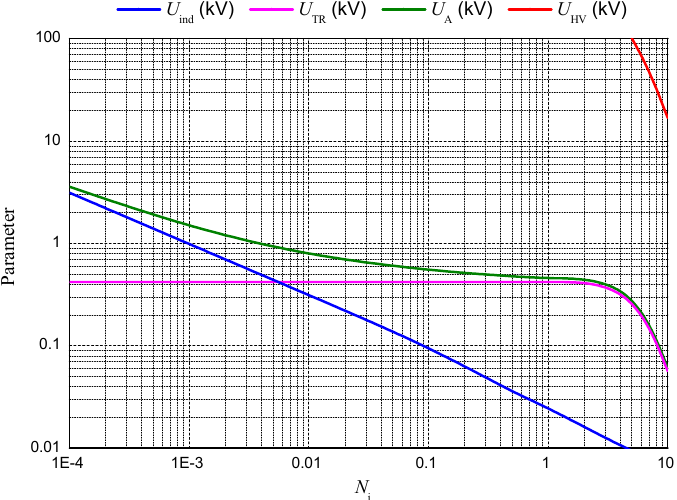
Figure 8. Trend of the voltage components that build up the voltage U A for LV circuits in multipo- lar cable.